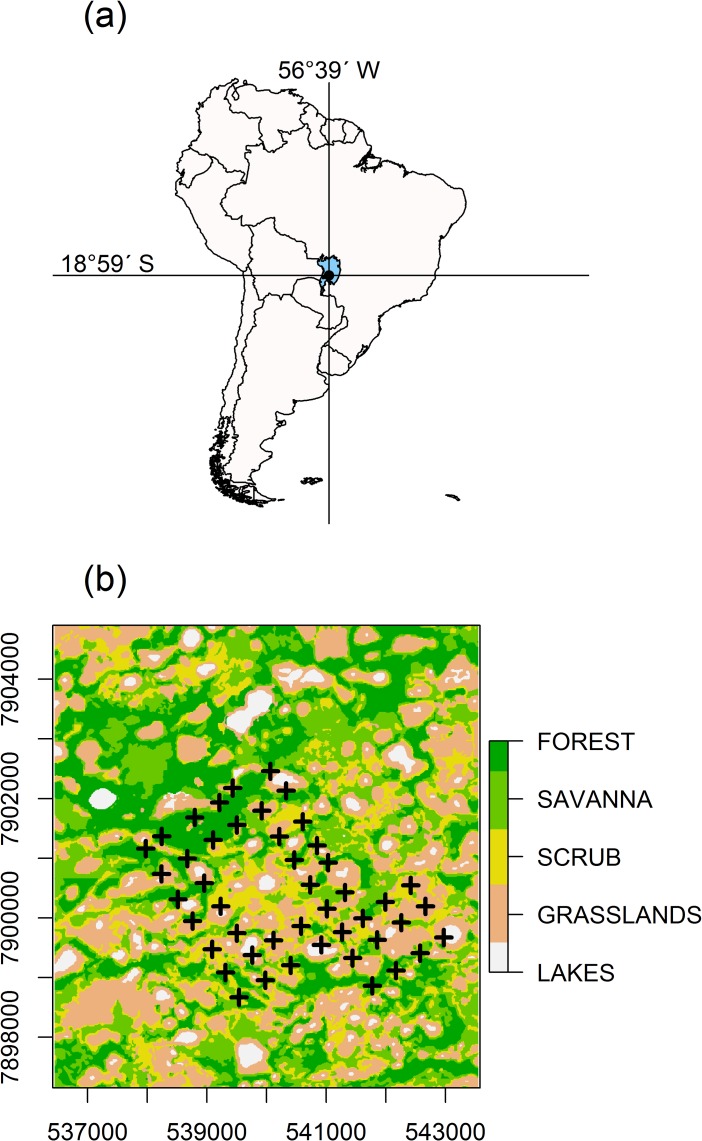
(a) Map of South America showing the Brazilian Pantanal (in blue). The lines cross at the study area (Nhumirim Ranch and neighboring areas); (b) thematic map of the study area showing the grid of camera-traps. The coordinates of the thematic map are shown as meters in zone 21k of the Universal Transverse Mercator system.